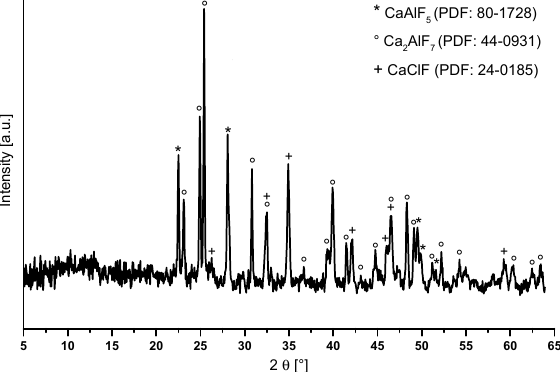
Figure 6. Powder diffractogram of annealed Ca 2 AlF 7 xerogel at 700 ° C for two minutes with reflections of Ca 2 AlF 7 , CaAlF 5 , and CaClF.